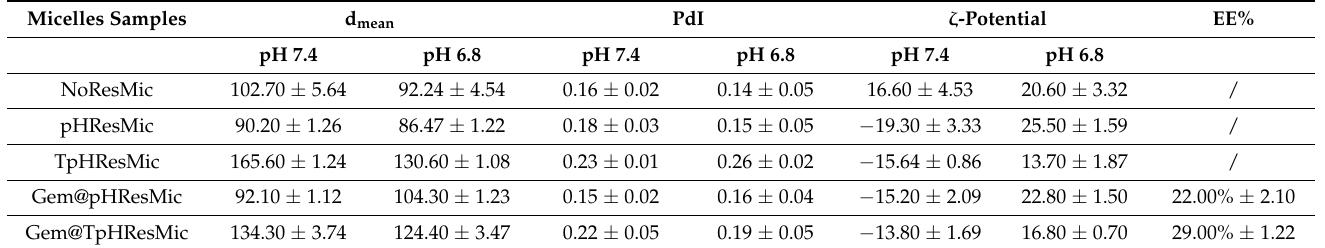
Table 2. Intensity average hydrodynamic diameter and corresponding PdI, determined by DLS, ζ -potential value, and drug encapsulation efficiency (EE%) of all prepared